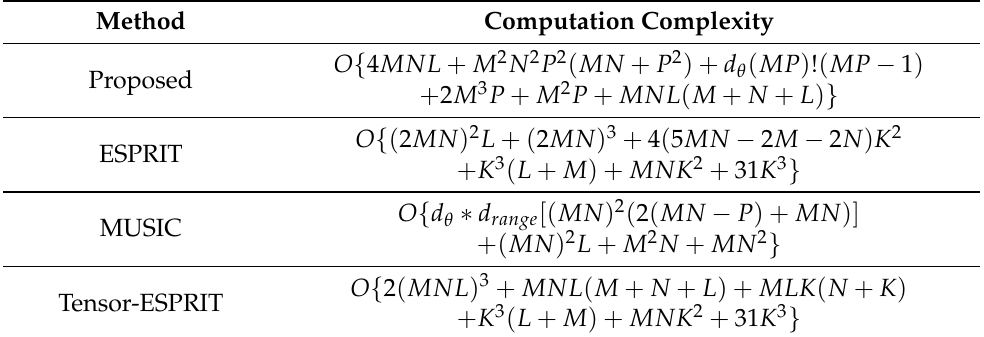
Table 2. Computation complexity